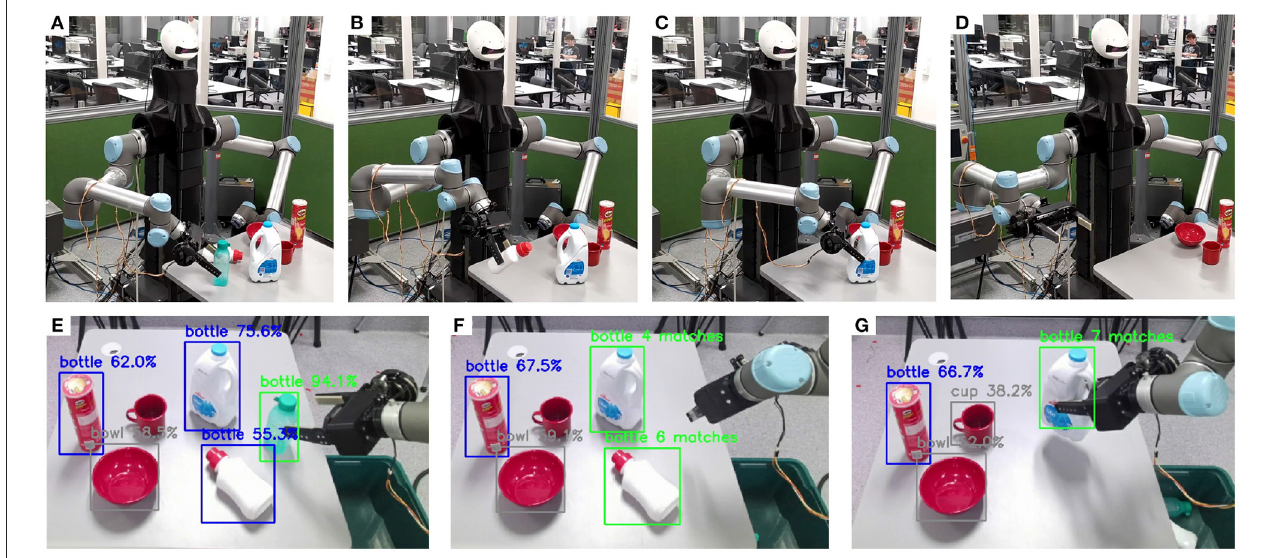
FIGURE 9 | Instances from the execution of the object identification experiment that facilitates autonomous robot grasping. The top row shows the robotic platform executing the experiment. The bottom row shows the camera field of view with the detected objects. (A–C) Present the robotic platform grasping and disposing bottles placed arbitrarily on a table, while (D) presents the completed bottle sorting task. (E) Presents the camera view during grasping of the bottle that was identified with high confidence by the CNN. (F,G) Present the camera view during grasping of bottles that were identified with low confidence by the CNN, but confirmed through the proposed attribute matching framework by the